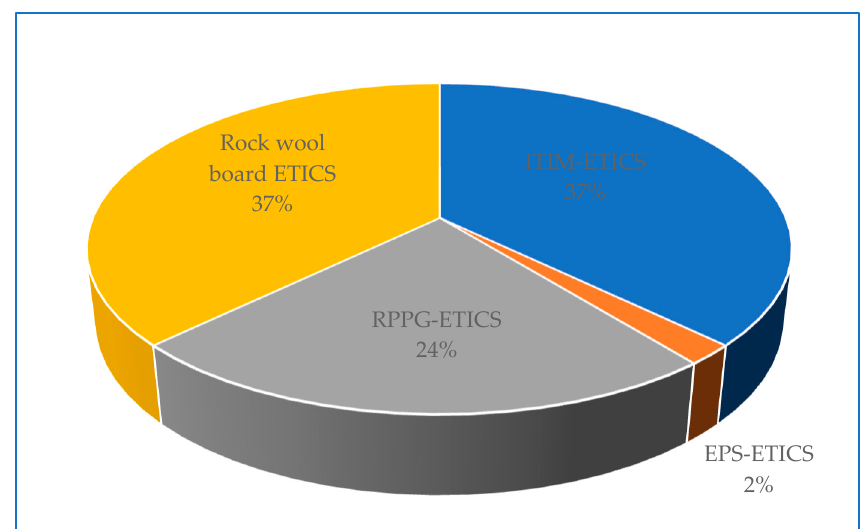
Figure 11. Proportion of types of ETICSs with swelling defect in the insulation layer.